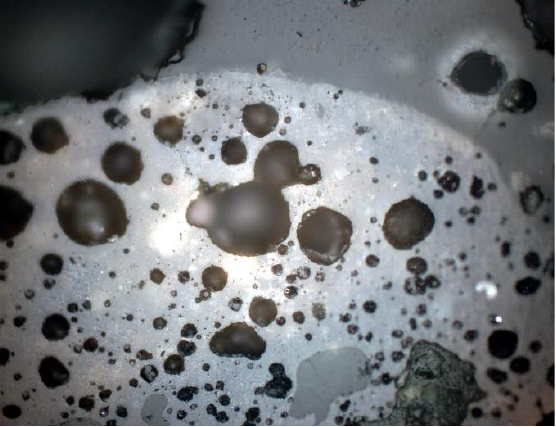
Figure 28. Closed pores visible under a petrographic microscope, polished section, 1P, 100×, reflected light.